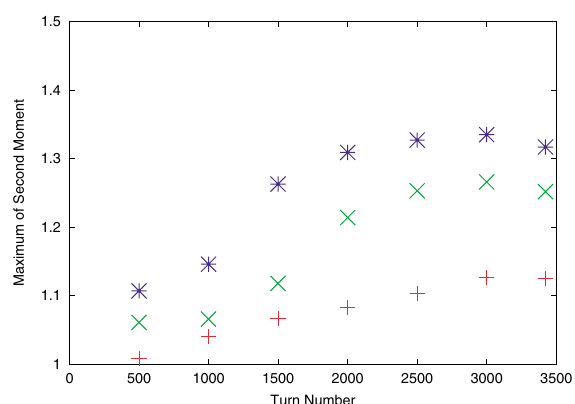
(cid:4) (cid:5) ; (cid:4) x y